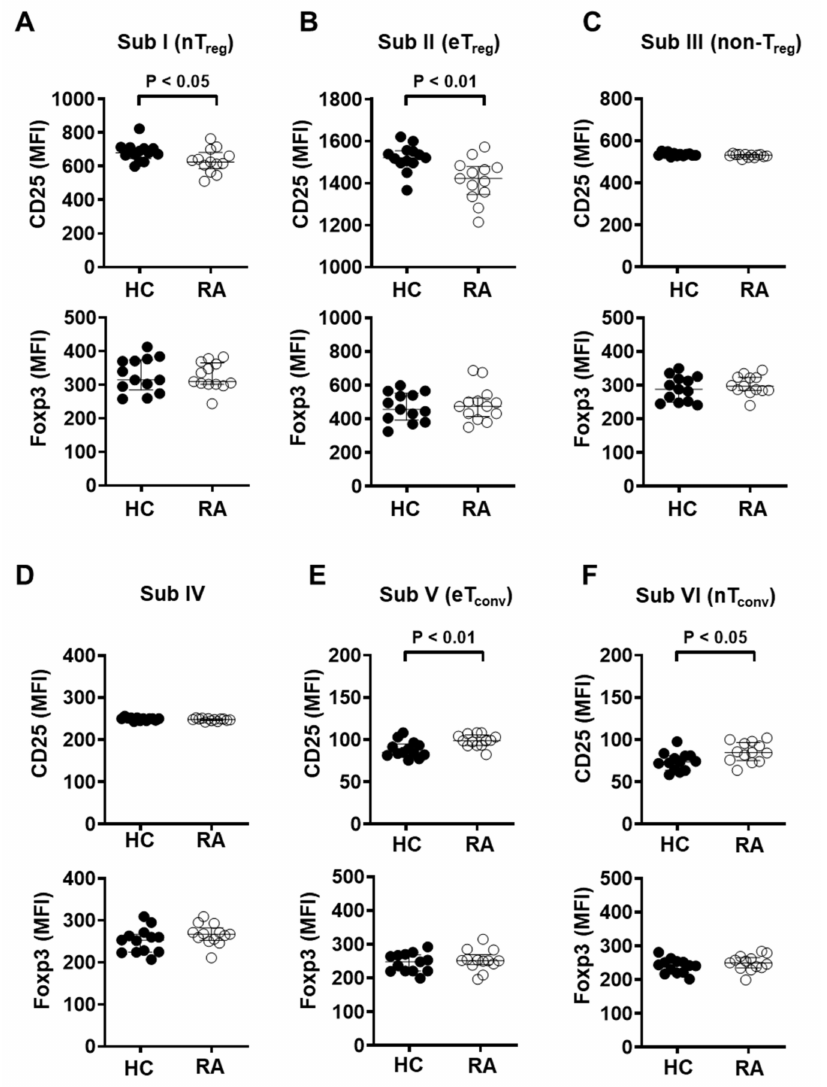
Figure 4. Naïve and effector T reg subpopulations from RA patients showed significantly reduced CD25 expression. Expression of CD25 and Foxp3 was measured by flow cytometry in each CD4 + T cell subgroup from healthy controls (HC, n = 13) and RA patients (RA, n = 13). Subgroups were as follows: ( A ) I (CD25 int CD45RA + cells), ( B ) II (CD25 hi CD45RA − cells), ( C ) III (CD25 int CD45RA − cells), ( D ) IV (CD25 low CD45RA − cells), ( E ) V (CD25 − CD45RA − cells), and ( F ) VI (CD25 − CD45RA − cells). Statistical differences were calculated by Mann–Whitney